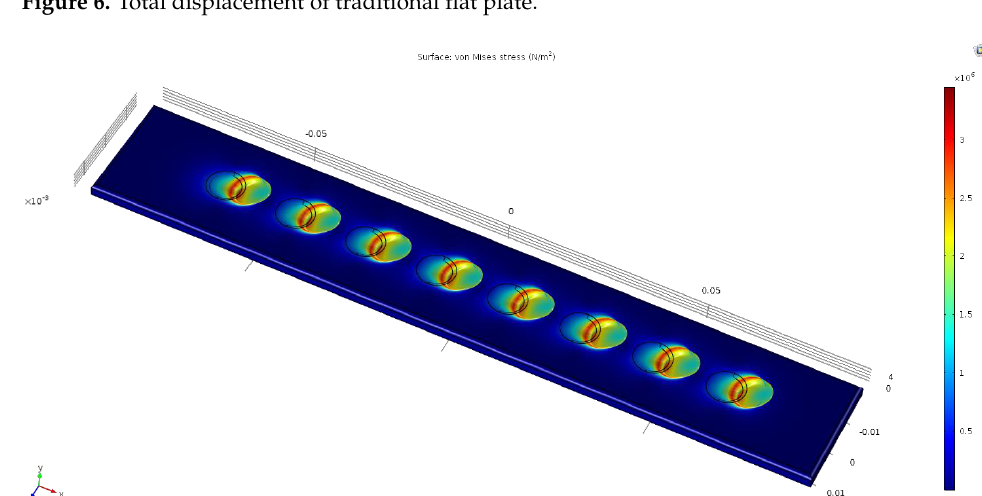
Figure 7. Von Mises stress of traditional flat plate.